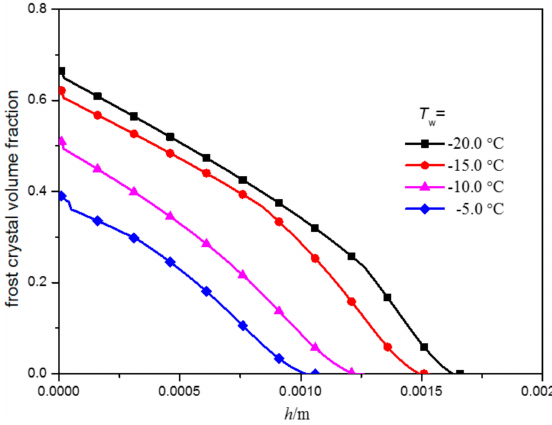
Figure 8. Distribution of frost crystal volume fraction in the frost